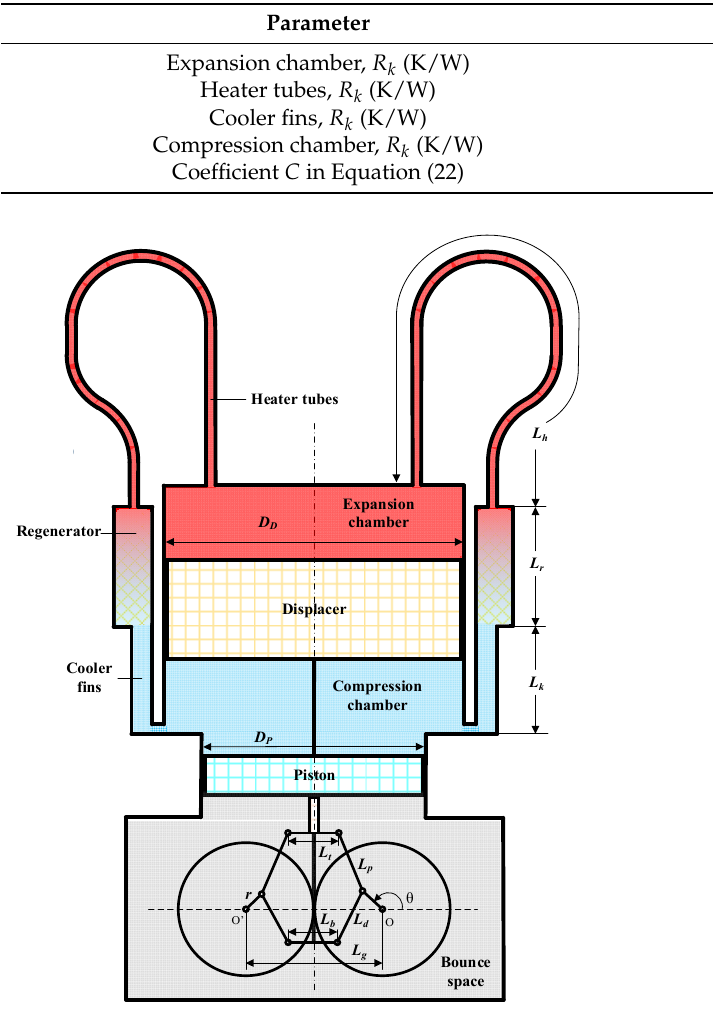
Figure 3. Schematic diagram of the small-scale β -type Stirling engine.